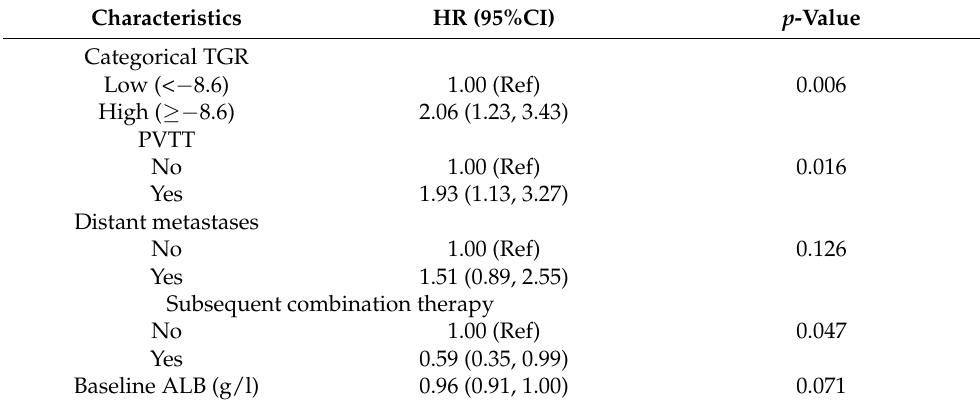
Table 2. Multivariate Cox regression analyses for overall survival in HHCC